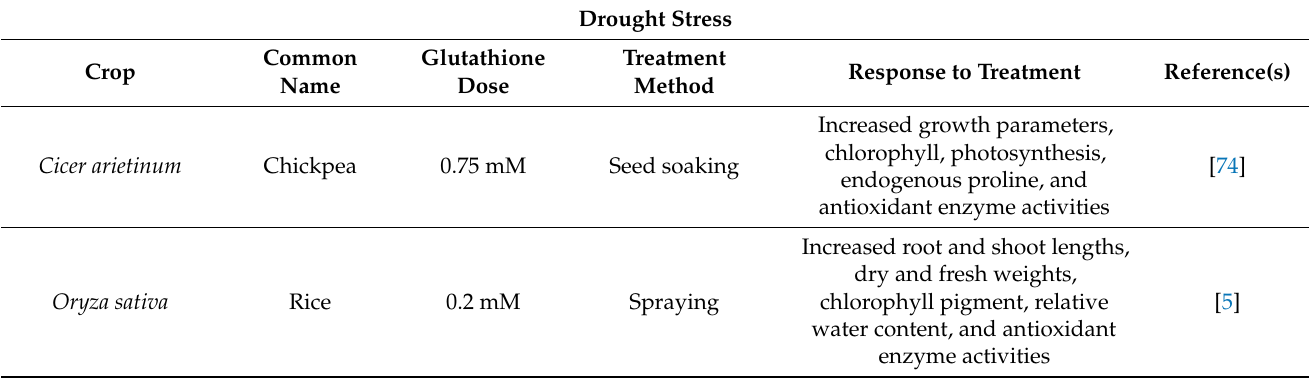
Table 6. Physiological responses of various crops to glutathione treatment against drought stress. Drought